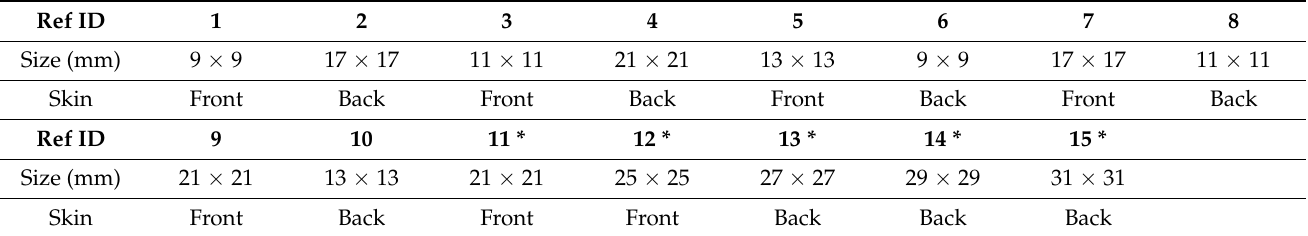
Table 4. Dimensions of the artificial Teflon defects for the sandwich